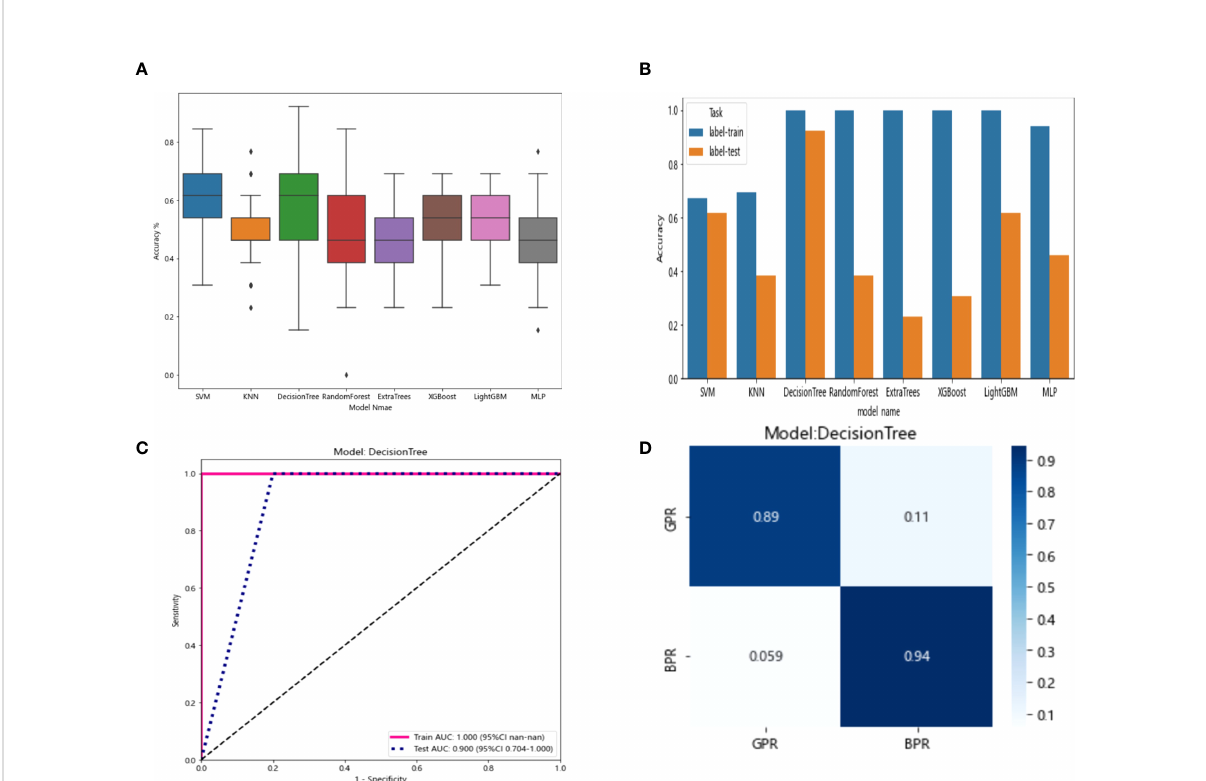
FIGURE 10 (A) Each model ’ s accuracy distribution was randomly tested 100 times by eight common machine learning algorithms. (B) Comparison of the accuracy of the best performing one out of 100 randomizations in eight machine learning algorithms. (C) AUCs of the training set and test set in the DecisionTree model. (D) Confusion matrix for the DecisionTree